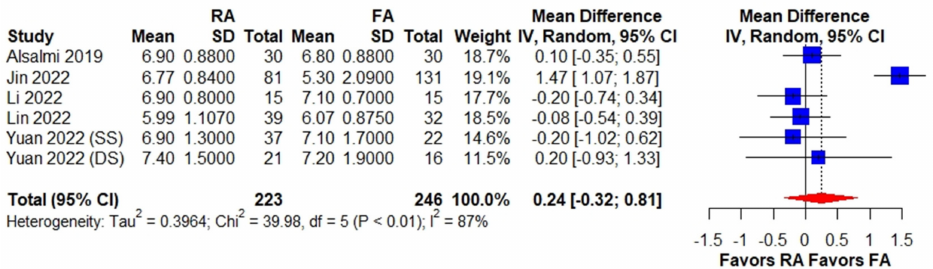
Figure 2. Forest plot of preoperative VAS among patients receiving RA PKP versus FA PKP. The forest plot demonstrates preoperative VAS among the RA PKP group versus the FA PKP group. The size of squares is proportional to the weight of each study. The result is summarized using weighted mean difference with corresponding 95% confidence interval (CI). Horizontal lines indicate the 95% CI of each study; the red diamond indicates the pooled estimate with 95% CI. CI, confidence interval, FA PKP, fluoroscopy-assisted kyphoplasty, RA PKP, robot-assisted kyphoplasty, VAS, visual analog scale